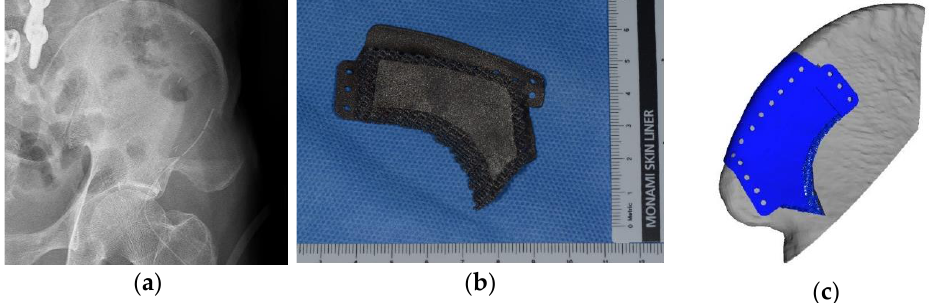
Figure 7. ( a ) Fractured donor site; ( b ) the 3D-fabricated titanium implant; ( c ) computer-based planning and designed titanium implant.